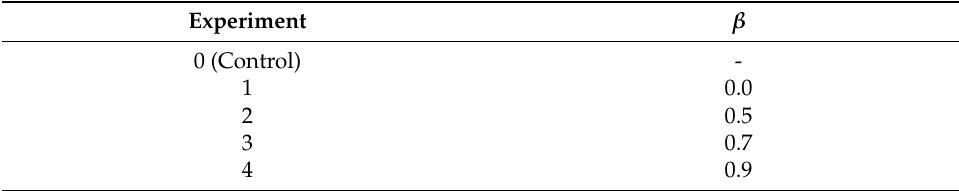
Table 2. Different experiments used in this study. The control run utilizes the simple, low-dimensional, time-invariant source term formulation described in Section 2.1 (and in previous studies). The other experiments employ the new time variable formulation of Section 2.2 and differ in the correlation cutoff β used to constrain the random temporal perturbations in the source height; β = 0 represents unconstrained perturbations while β → 1 represents perturbations highly correlated with the a priori height function H a ( t ) . Experiment β 0 (Control) - 1 0.0 2 0.5 0.7